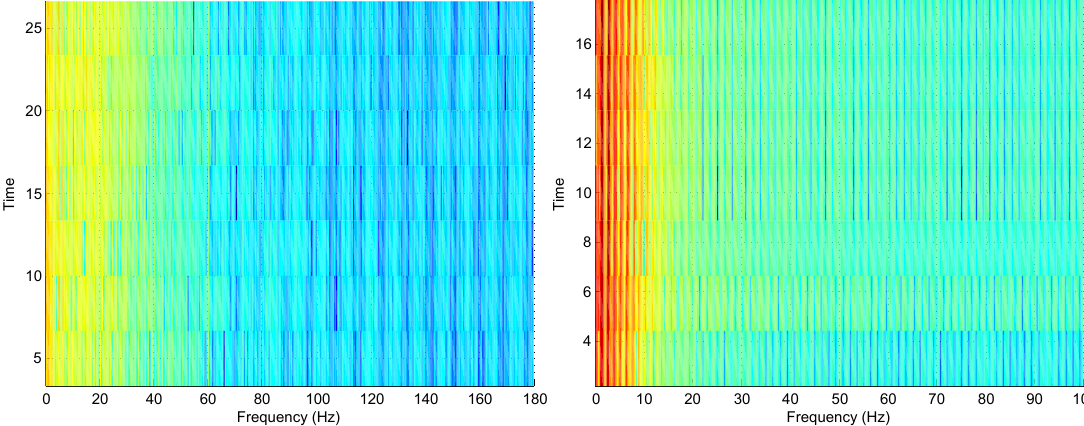
Figure 4. Spectrogram for ECG signal ( left ) and PPG signal ( right ) shown in Figure